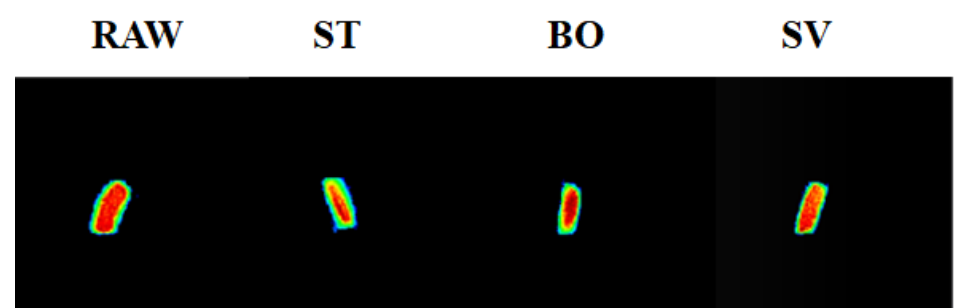
Figure 2. MRI images of the squid ( Symplectoteuthis oualaniensis ) mantle muscle with different cooking treatment. RAW: raw squid; ST: steaming; BO: boiling; SV: sous vide. The blue color indicates a lower proton density, while red color indicates a higher proton density.